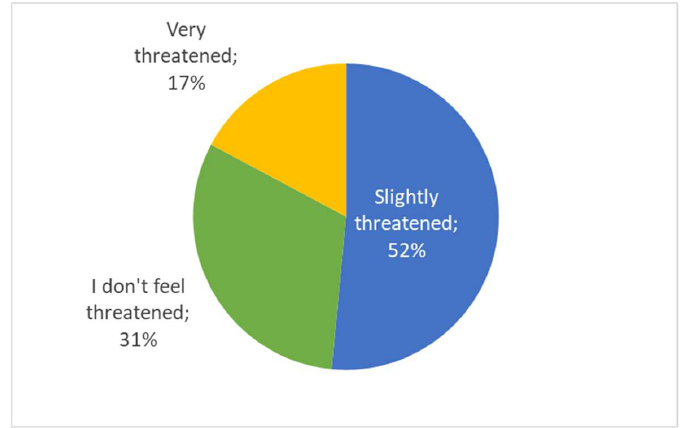
Figure 11. Do you feel threatened by AI? N = 99.